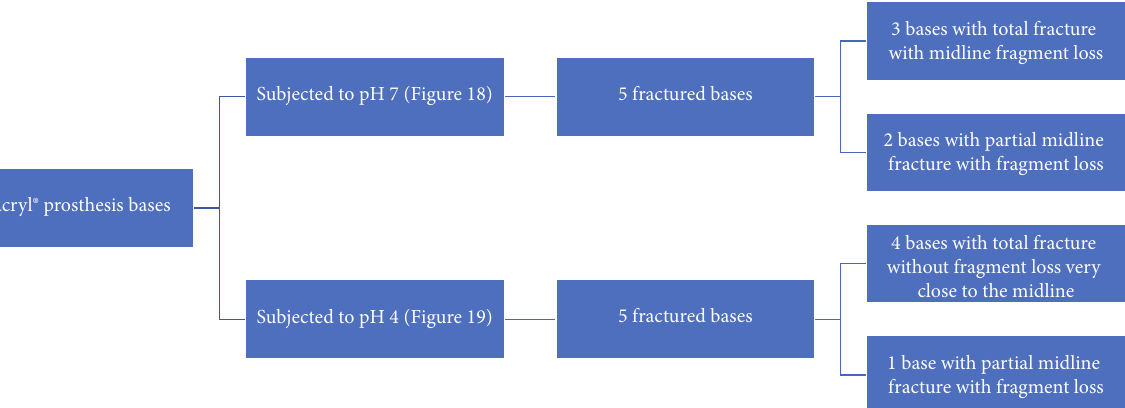
Figure 13: Observations concerning the fracture resistance performance of the acrylic Megacryl ® plates.